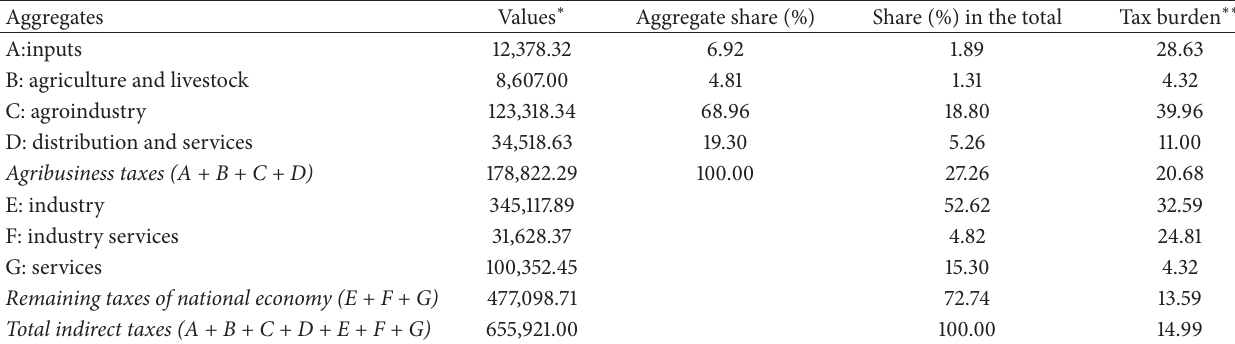
Table 3: Indirect taxes and tax burden of Brazilian economy, 2011.